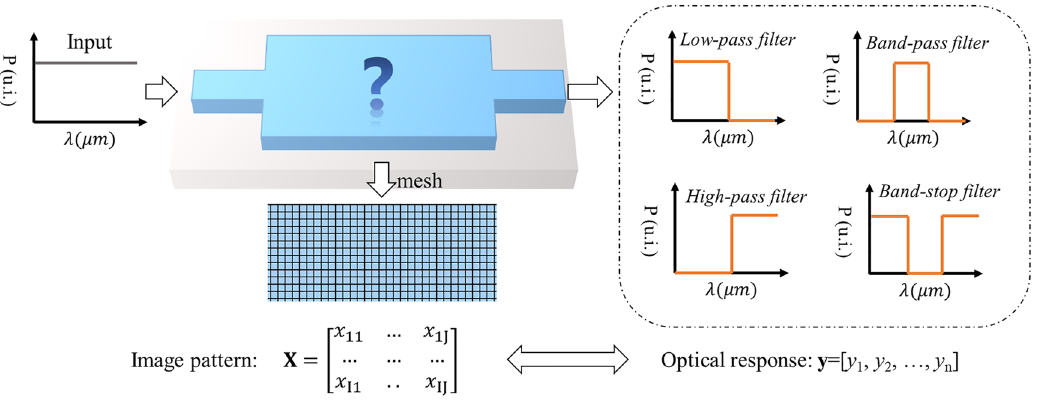
Figure 3: Schematic of the wavelength filter on SOI platform. Various transmission spectra can be achieved with different patterns in the middle slab region.